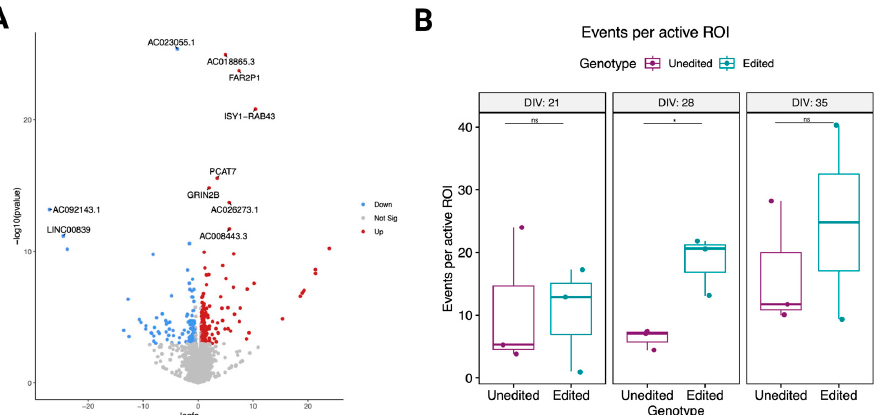
Figure 4. Introducing variants in the proline-rich region of CASKIN1 causes significant transcriptomic and neuronal activity changes in glutamatergic iPSC-derived neurons. ( A ) Volcano plot showing RNA-seq significantly DEG (padj < 0.05) in color plotted against their magnitude of change (log fold change) where all dots in blue are downregulated and all red dots are upregulated. Each dot is a gene and the top 10 genes are labeled. ( B ) Calcium imaging data showing the number of events per active ROIs in edited (teal) and unedited (purple) cells across 3 time points: DIV21, DIV28, and DIV35, where the edited cells are seen to be more active on DIV28 (nominal p ‐ value: 0.0348) compared to DIV21 ( p ‐ value: 0.941) and DIV35 ( p ‐ value: 0.692).